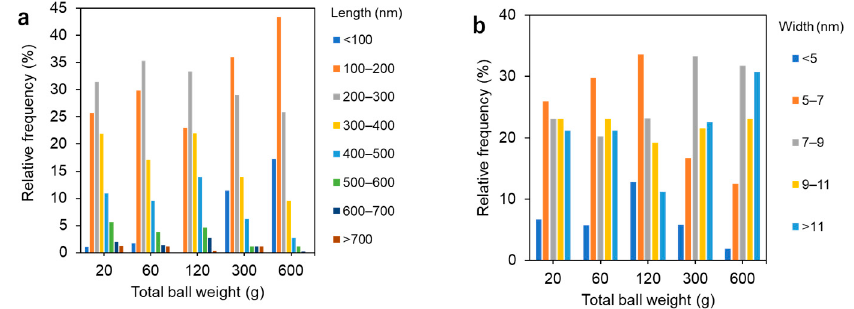
Figure 6. Distribution of ( a ) length and ( b ) width of chitin nanofibers milled at different total ball weights.